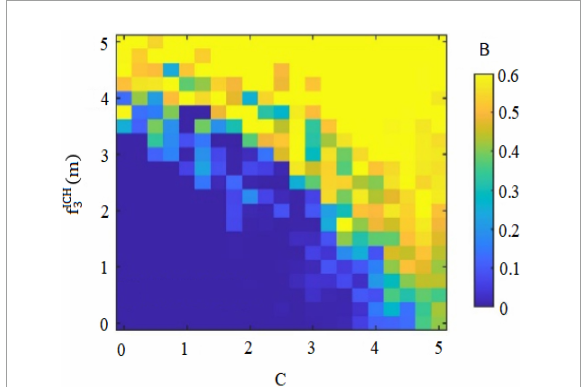
FIGURE4 Psychological capital, perceived benefits and deviant innovation behavior (high risk-taking traits).